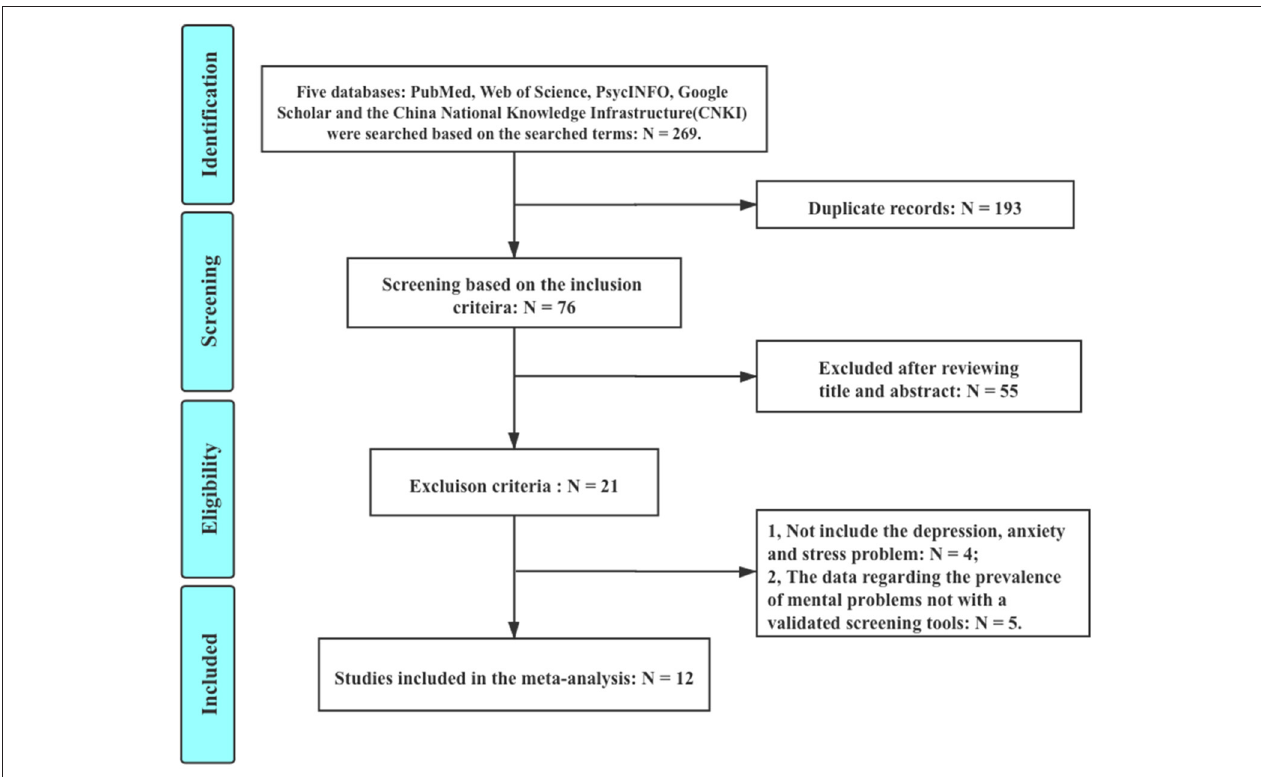
FIGURE 1 | Flowchart of the identification for the included